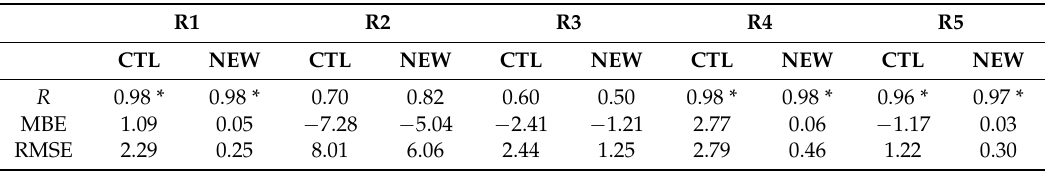
Table 2. Statistical characteristics of annual GPP for the five grouped regions compared to MTE data. (Values with asterisks represent R values with significance at the 95% confidence level ( p < 0.05), and the units for MBE and RMSE are g C m − 2 year − 1 .) R1